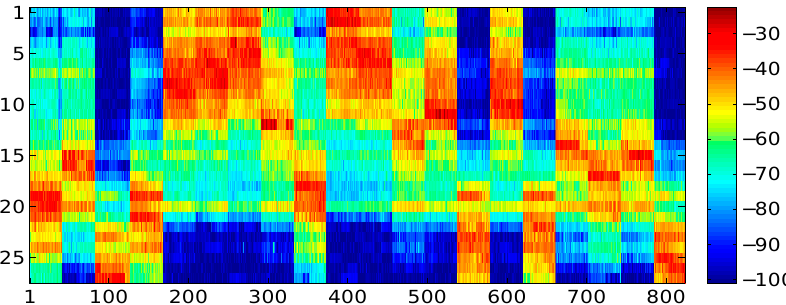
Figure 11. Recovered radio map by SVT when five access points powered off